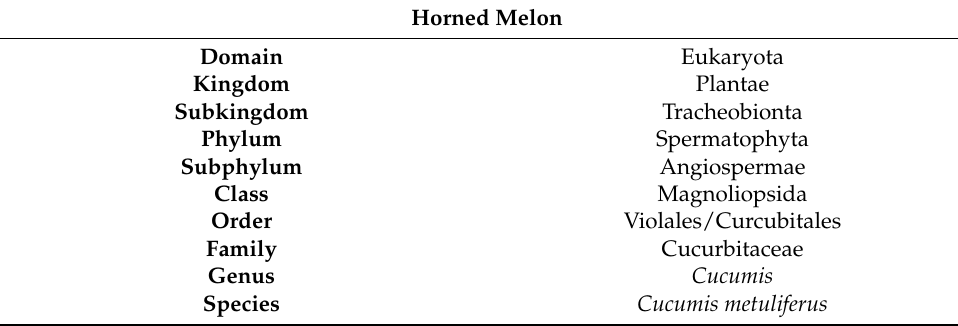
Table 1. Taxonomic classification of horned